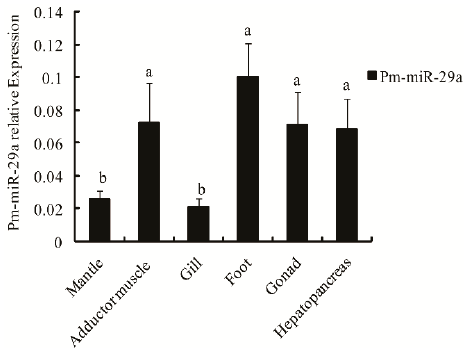
Figure 2. Expression levels of Pm-miR-29a in different tissues. qRT-PCR was done with RNA samples from the adductor muscle, gill, mantle, hepatopancreas, gonad, foot. U6 snRNA was used as the internal reference gene. Different letters mean a significant difference in all detected tissues ( p < 0.05). Error bars correspond to mean ± SD.